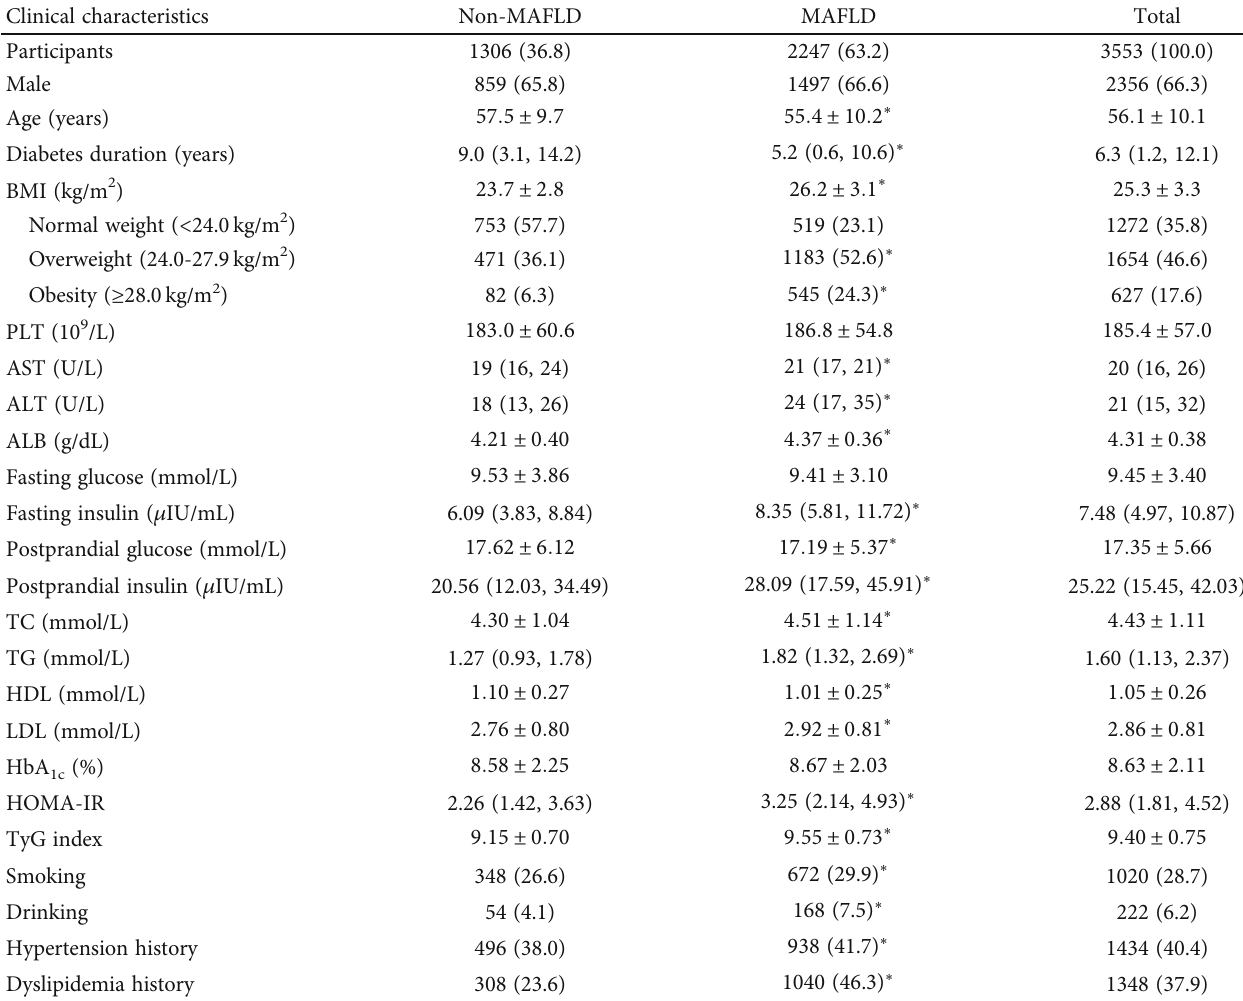
Table 1: Clinical characteristics of the study